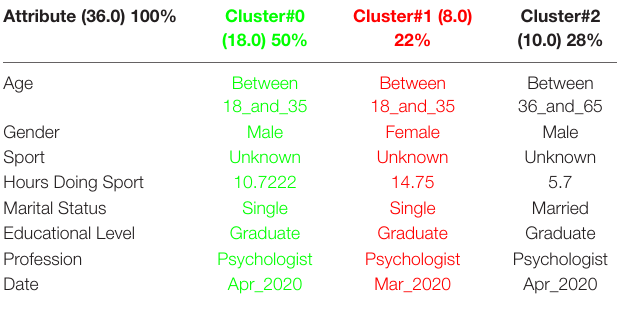
TABLE 4 | 3 clusters STAI analysis for March to May